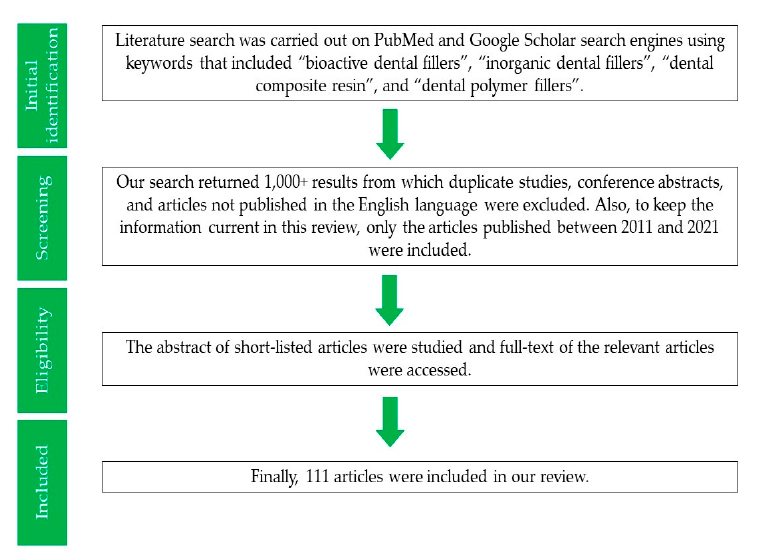
Figure 2. Flowchart depicting methodology adapted in our study.